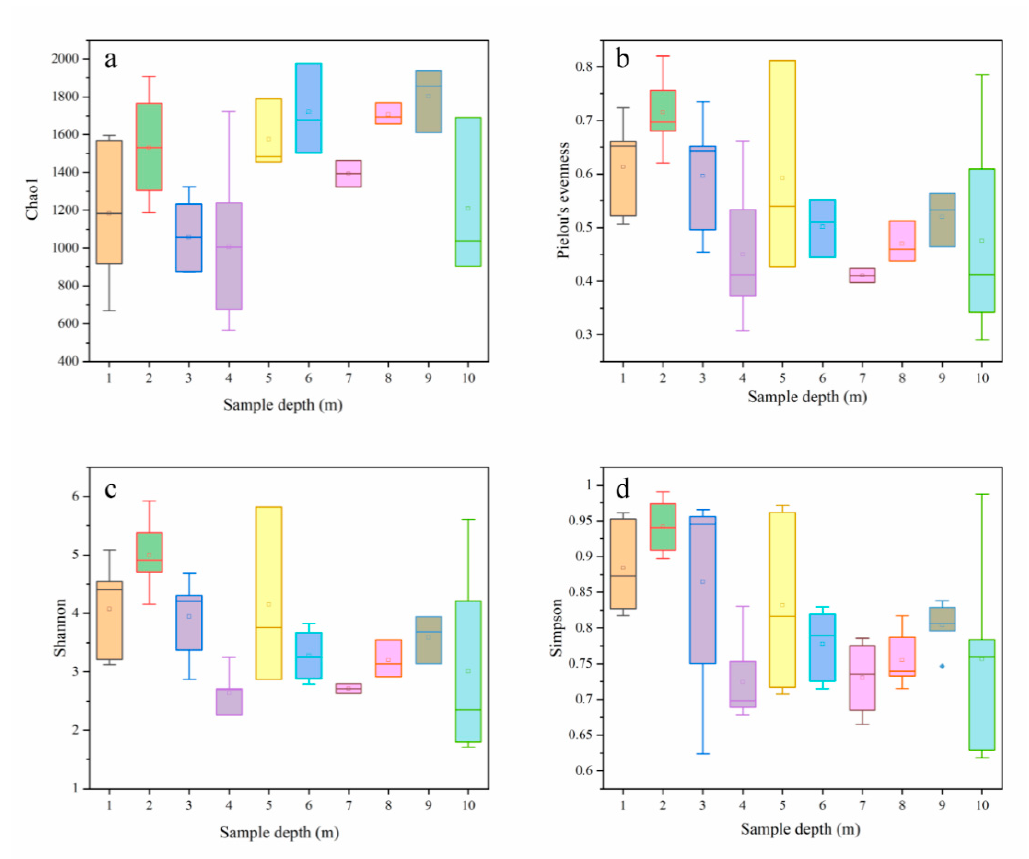
Figure 4. Chao1 index ( a ), Pielou’s evenness index ( b ), Shannon’s diversity index ( c ), and Simpson’s index of diversity ( d ) in soil at different depths.